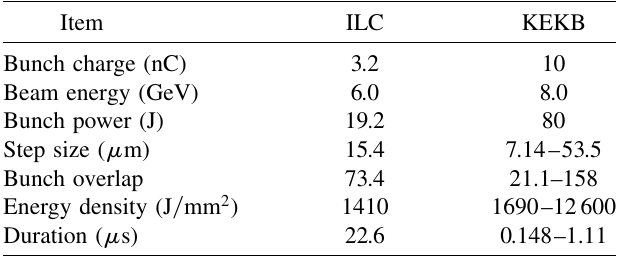
TABLE II. Summary of the beam parameters and expected energy deposited in the ILC drive beam and KEKB stored beam. For ILC, 50 m = s target rotation is